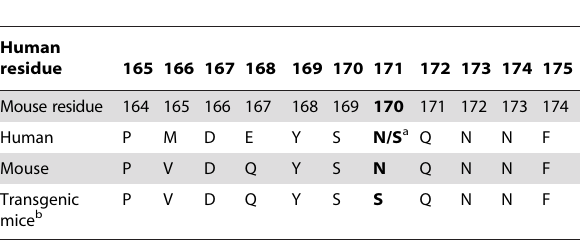
Table 1. Comparison of PrP residues in humans, mice and transgenic mice generated in the present